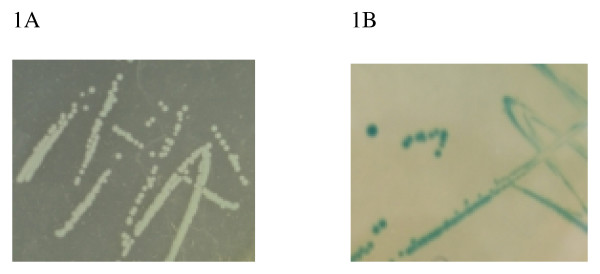
Atypical colonies of E. sakazakii FSM 322 (A) and typical colonies of S. ficaria (B) on DFI agar.